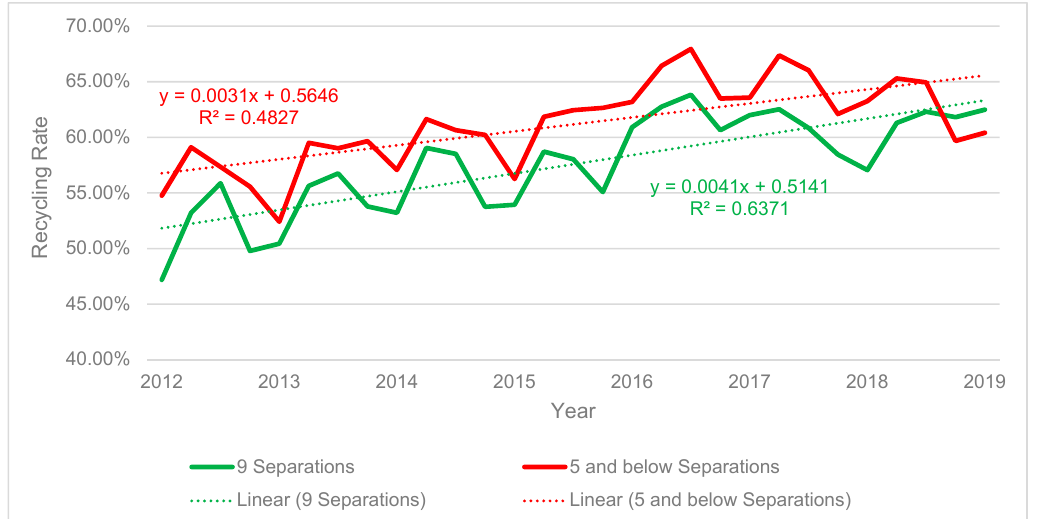
Figure 7. Total recycled waste of local authorities (LAs) with the most and least separated collection methods of kerbside waste per quarter. Source: WasteDataFlow and each LA website. Dotted lines (by colour) show trend lines represented also in figure by regression equations and coefficients of determination (R 2 ).